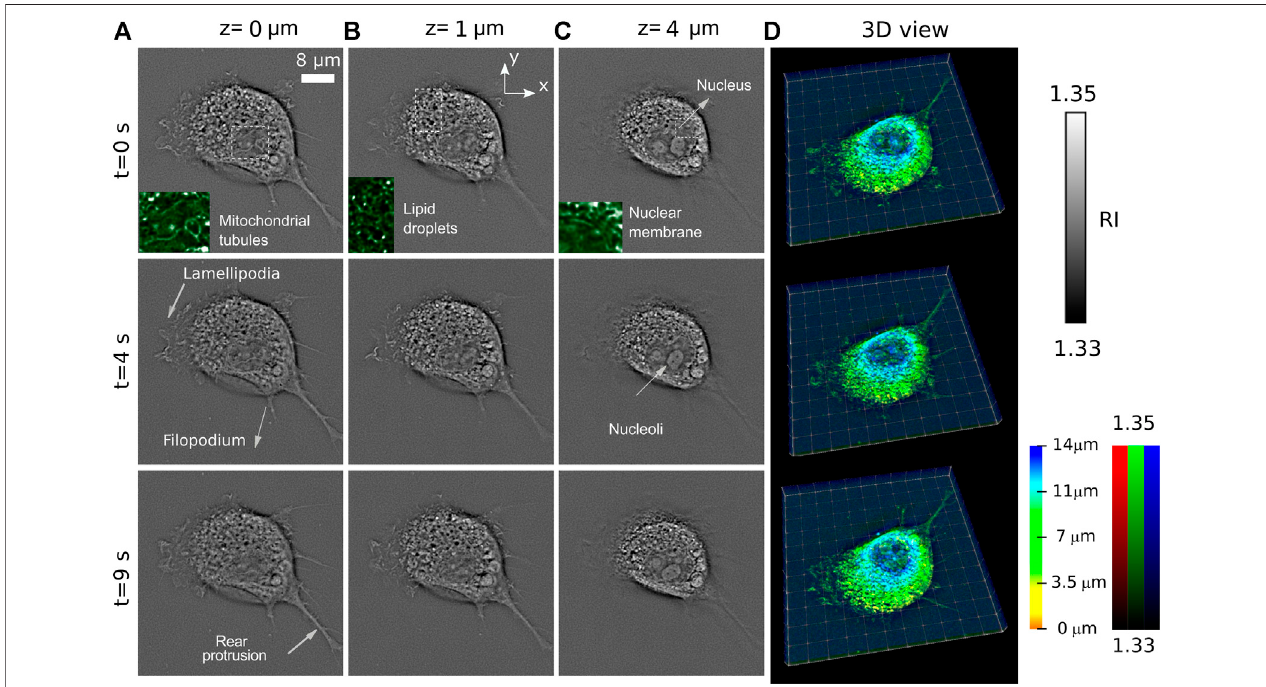
FIGURE2| TemporalevolutionofcellRIdistributionobservedatthreedifferentaxiallyseparatedslicesz (cid:2) 0 μ m (A) ,z (cid:2) 1 μ m (B) ,andz (cid:2) 4 μ m (C) ofalivingCOS-7 cell immersed in PBS solution. (D) 3D rendering with a color-coded depth and brightness-coded RI applied.